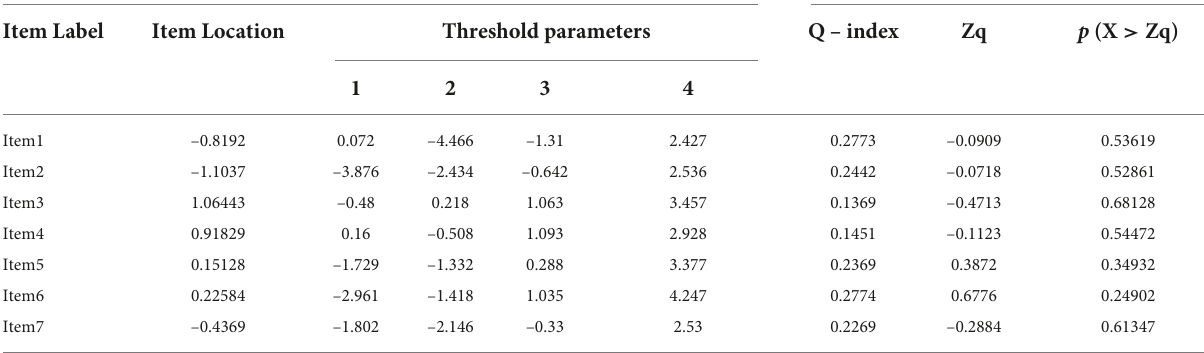
TABLE 4 Item threshold parameters and item fits assessed by the Q-index – Partial Credit